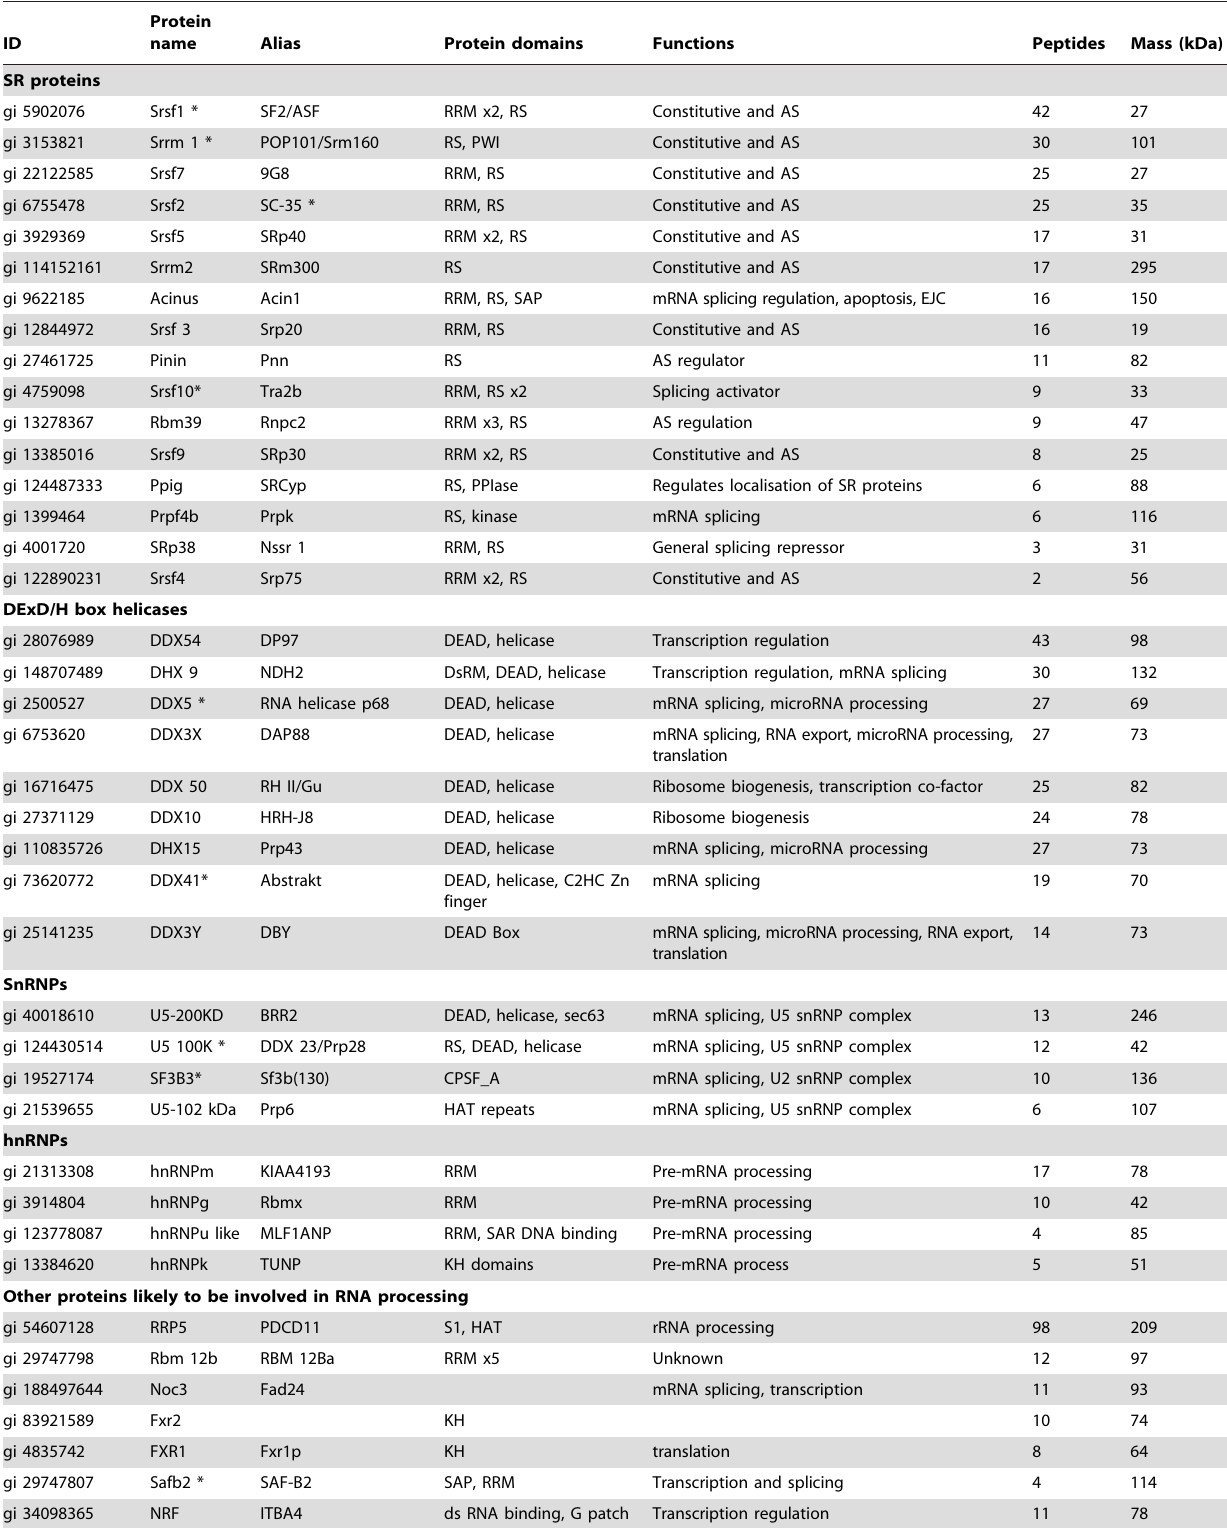
Table 1. Psip1/p52 interacting